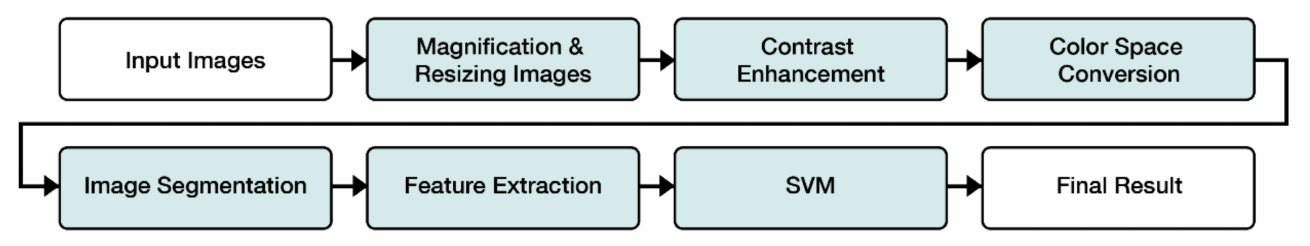
Figure 22. Proposed